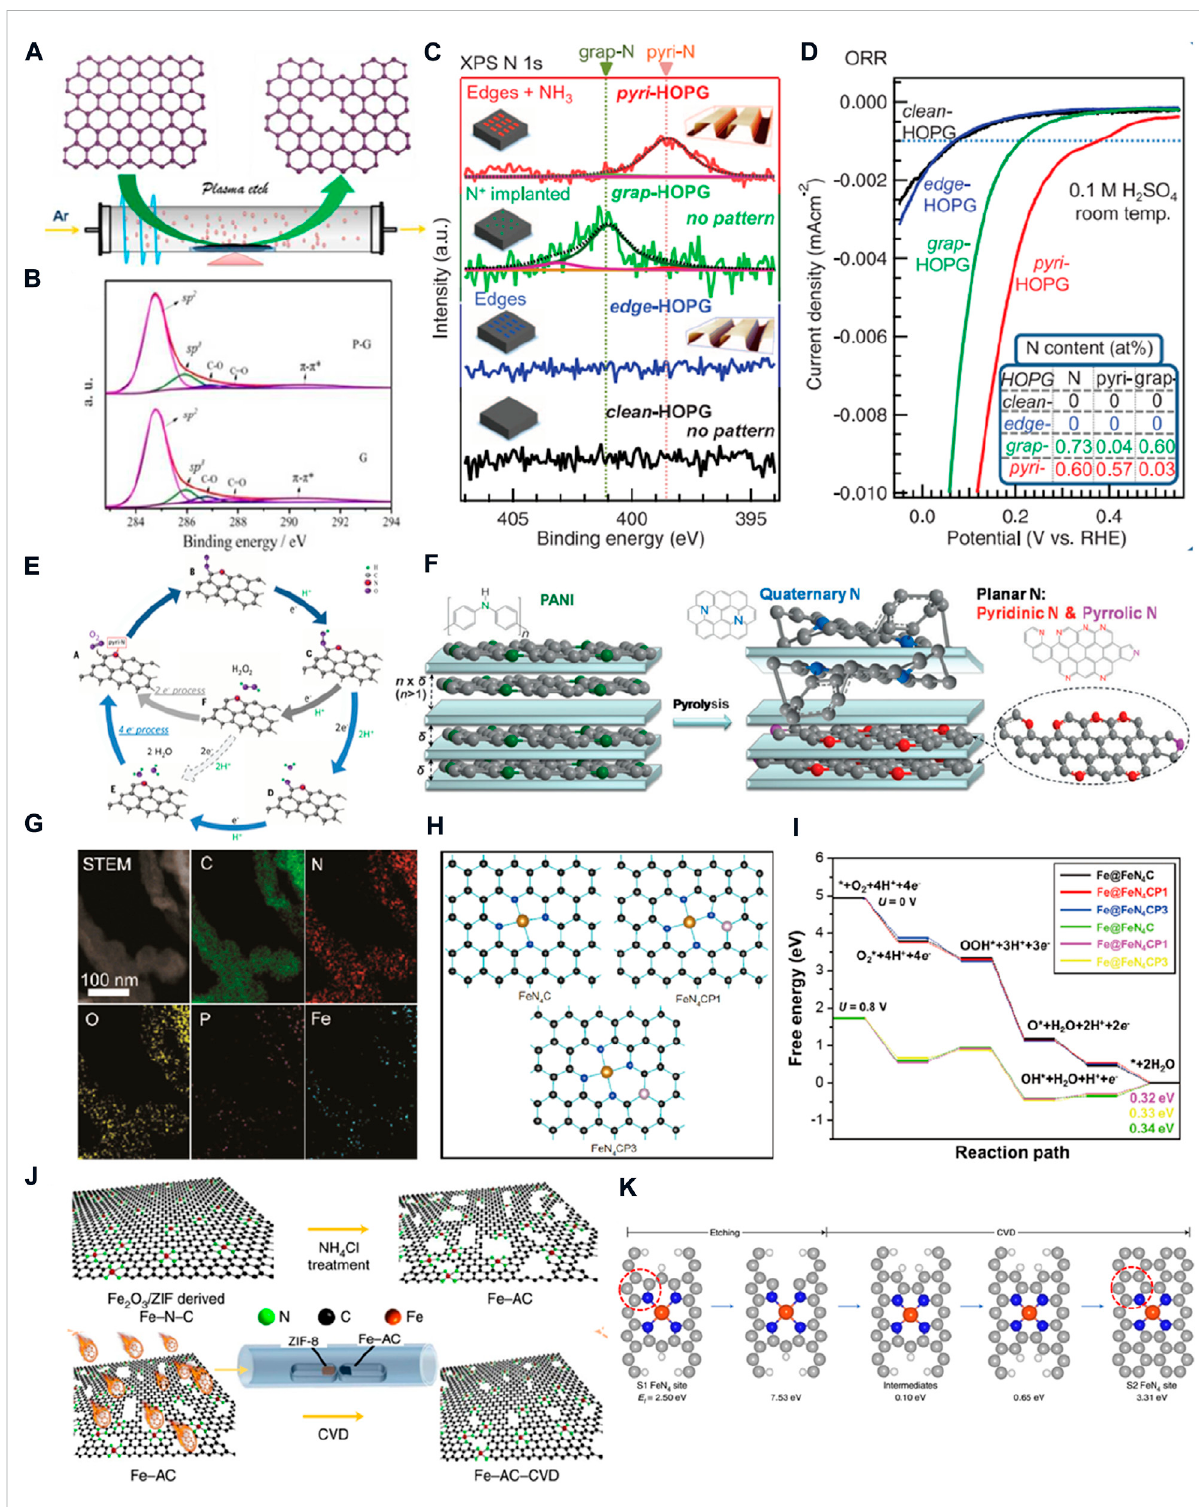
FIGURE 2 (A) Schematic diagramof theedge-rich graphene preparation. (B) C1s XPSspectraofgraphene and plasma-treated graphene (Taoetal., 2016). (C) N1s XPS spectra of model catalysts; (D) LSV curves of model catalysts; (E) Schematic for the ORR pathway on N-doped carbon materials (Guo et al., 2016). (F) Schematic representation showing the selectivity inside and outside of montmorillonite during nitrogen-doped graphene synthesis (Dingetal.,2013). (G) STEMimageandcorrespondingEDSelementmappingofP-dopedFe-N-C; (H) modelsofFeN 4 CP1andFeN 4 CP3; (I) free energy of the ORR on FeN 4 C, FeN 4 CP1, and FeN 4 CP3 sites (Li W. et al., 2020). (J) Schematic diagram of synthesizing a long-term durability Fe – N – C catalyst; (K) possible FeN 4 site conversion during the CVD process calculated by DFT (Liu et al.,